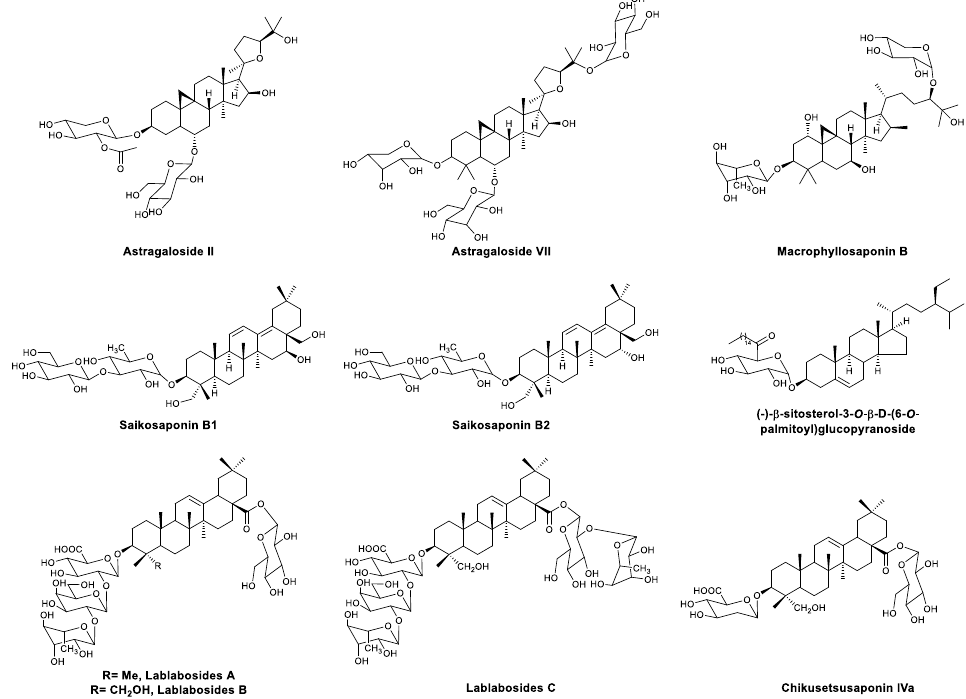
Figure 9. Structures of astragalosides II and VII; macrophyllosaponin B; saikosaponins B1 and B2; (−) - β -sitosterol-3-O- β -D-(6-O-palmitoyl)glucopyranoside; lablabosides A, B, and C; and chikusetsu- saponin IVa.